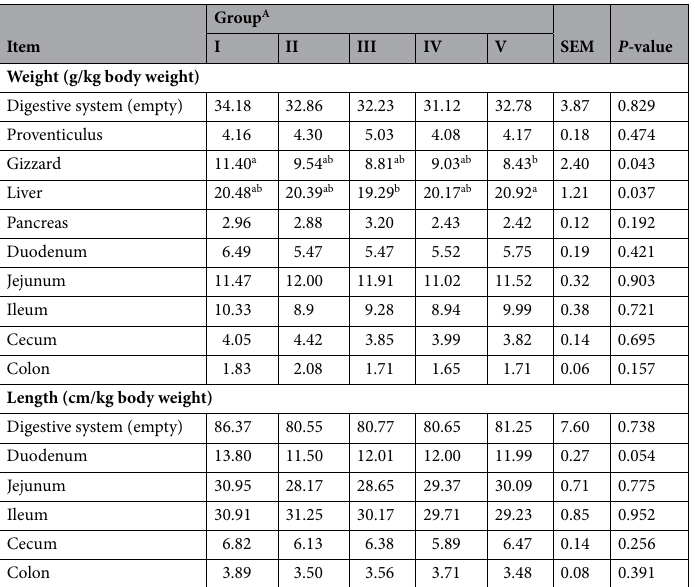
Table 3. Relative weight and length of individual sections of the digestive system of broiler chickens. SEM standard error of the mean. a,b Values with different letters in a row differ significantly, P < 0.05. A Groups II, III, IV, V were fed with halloysite and zeolite (1:3 ratio) at 0,5% (1–35 days) and 1% (36–42 days) level. Aluminosilicates were also used for the litter: II—500 g of halloysite/m 2 ; III—250 g of halloysite/m 2 and 250 g of zeolite/m 2 ; IV—500 g of zeolite/m 2 ; V – 130 g halloysite/m 2 , 370 g zeolite/m 2